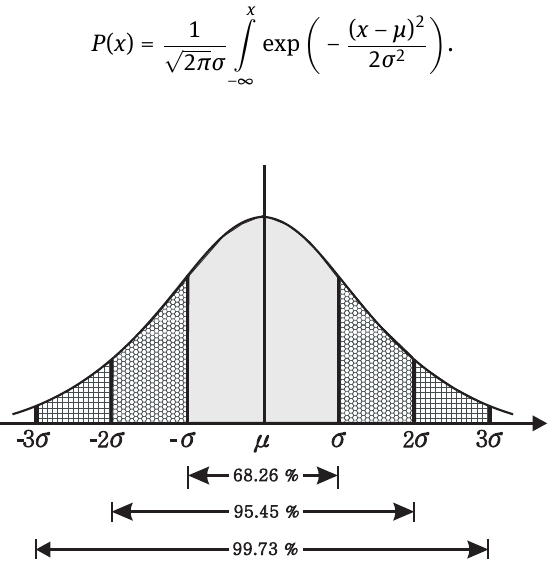
Figure 3: Normal density function